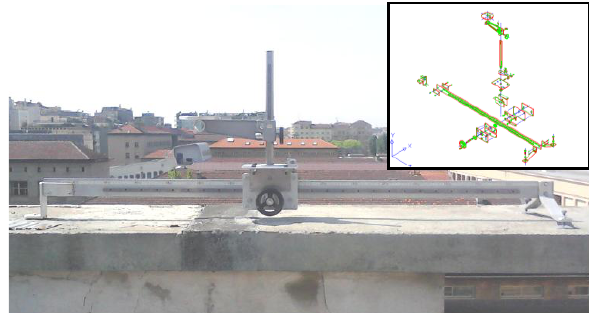
Figure 12. Micrometric slide for controlled